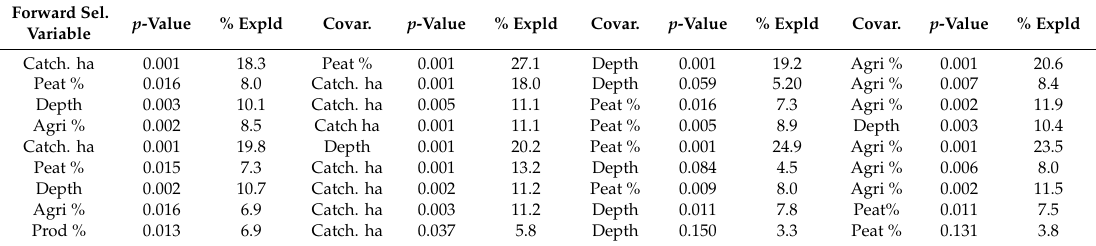
Forward selected subsets of variables that explain the chemical composition of the predisturbance (upper panel) and recent (lower panel) sediments. Peat extraction (Prod %) is also shown for recent sediments. The table shows percentages of explained variation in sediment chemistry and the associated p-values when the variables are supplied as sole variables or with the other variables as covariables. With covariables, the explained variation is after fitting the covariable. Forward Sel.